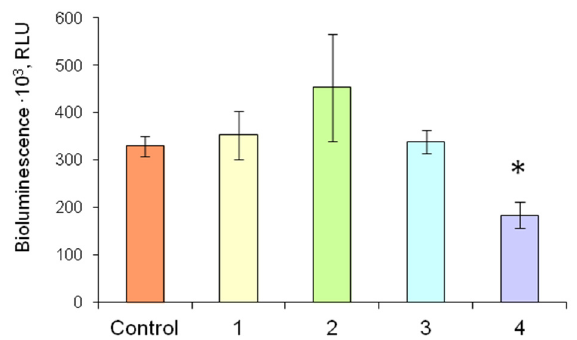
Figure 8. Luminescence intensity of the firefly luciferin-luciferase system in reaction mixtures of different compositions in the presence of 3 nM ATP: Control—Reaction mixture contained solutions of 4.2 µ g of FLuc and 2.5 mM D-luciferin; 1—Reaction mixture contained a solution of 4.2 µ g of FLuc and 2.5 mM D-luciferin immobilized in gelatin gel; 2—Reaction mixture contained a solution of 4.2 µ g of FLuc and 2.5 mM D-luciferin immobilized in starch gel; 3—Two different immobilized reagents based on gelatin gel—a disc with immobilized FLuc (4.2 µ g of FLuc in each disc) and a disc with immobilized D-luciferin (D-luciferin concentration was 2.5 mM)—were added to the reaction mixture; 4—The multicomponent reagent containing 4.2 µ g of FLuc and 2.5 mM D-luciferin co-immobilized in gelatin gel was added to the reaction mixture. * p < 0.05 compared with the control.